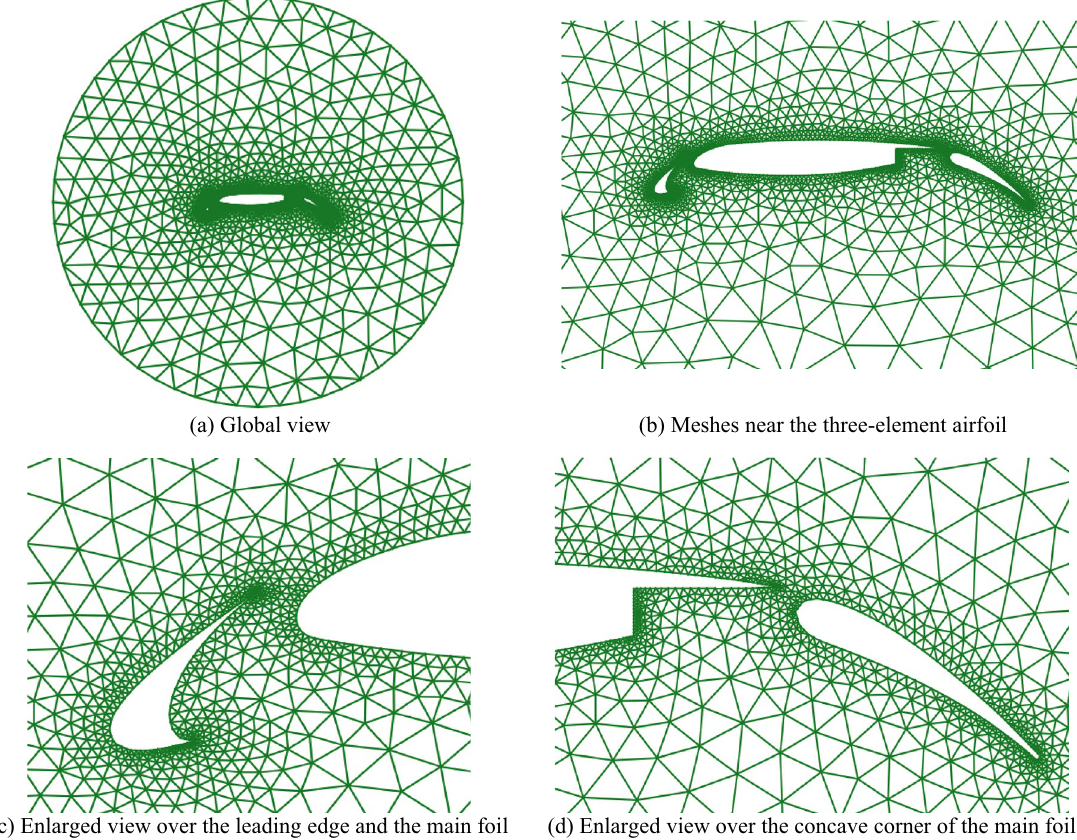
Figure 17. Triangular mesh generation over a three-element airfoil.